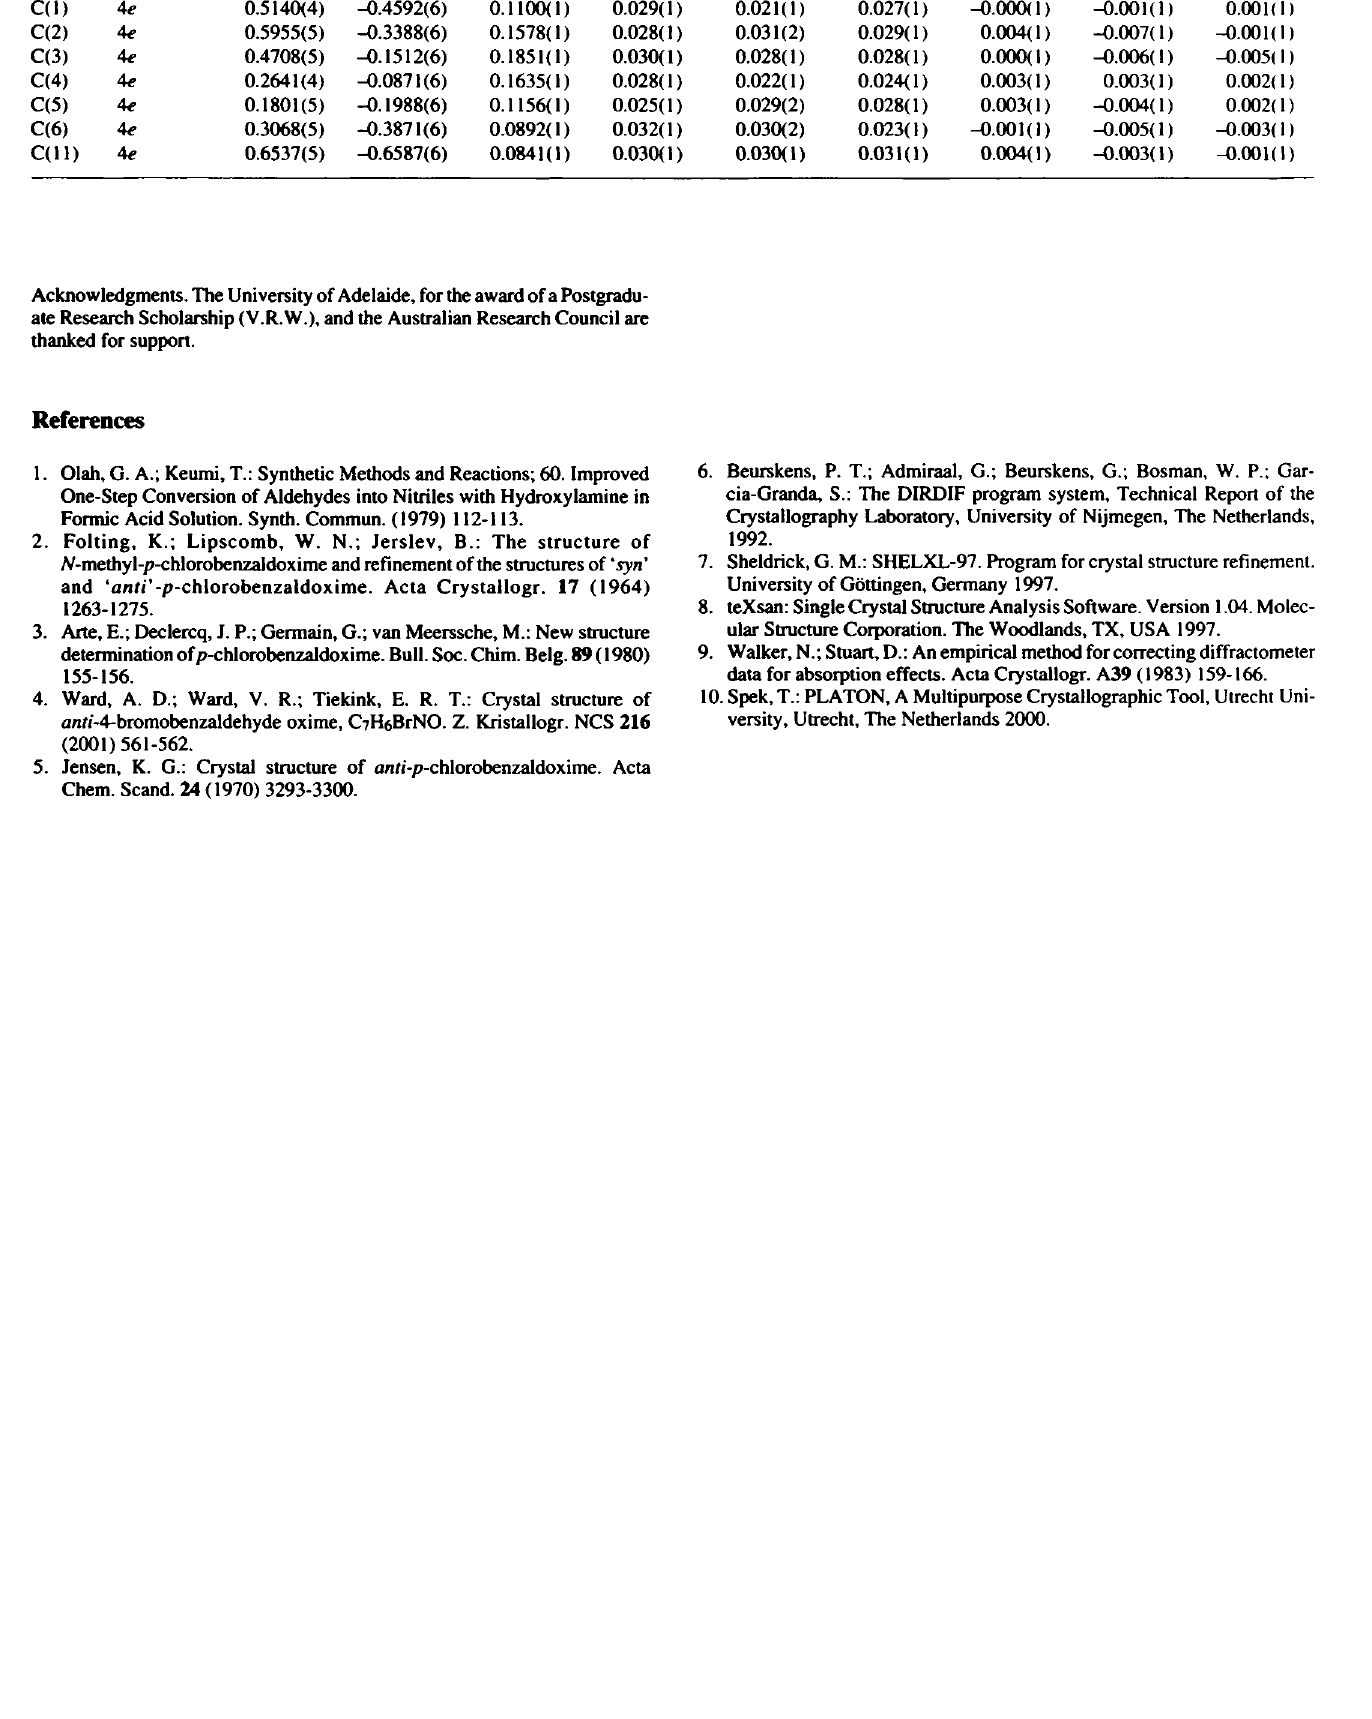
Table 3. Atomic coordinates and displacement parameters (in Ä 2 ).